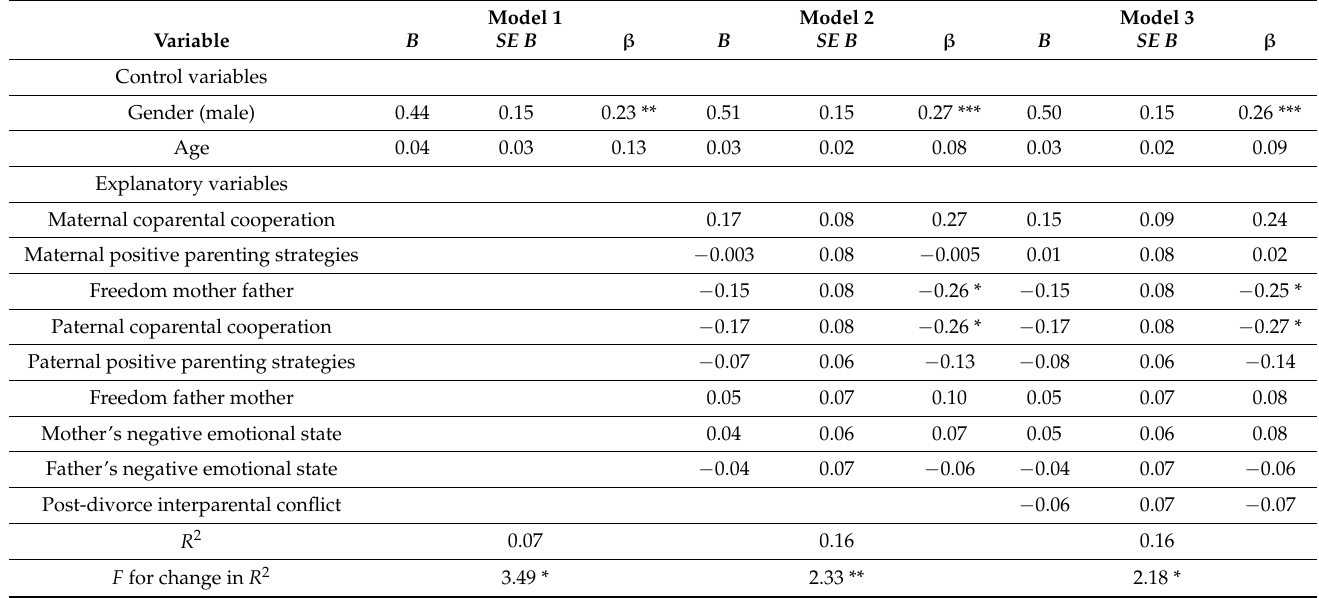
Table 3. Summary of hierarchical multiple regression for some variables related to the parental divorce process predicting attachment-related avoidance.